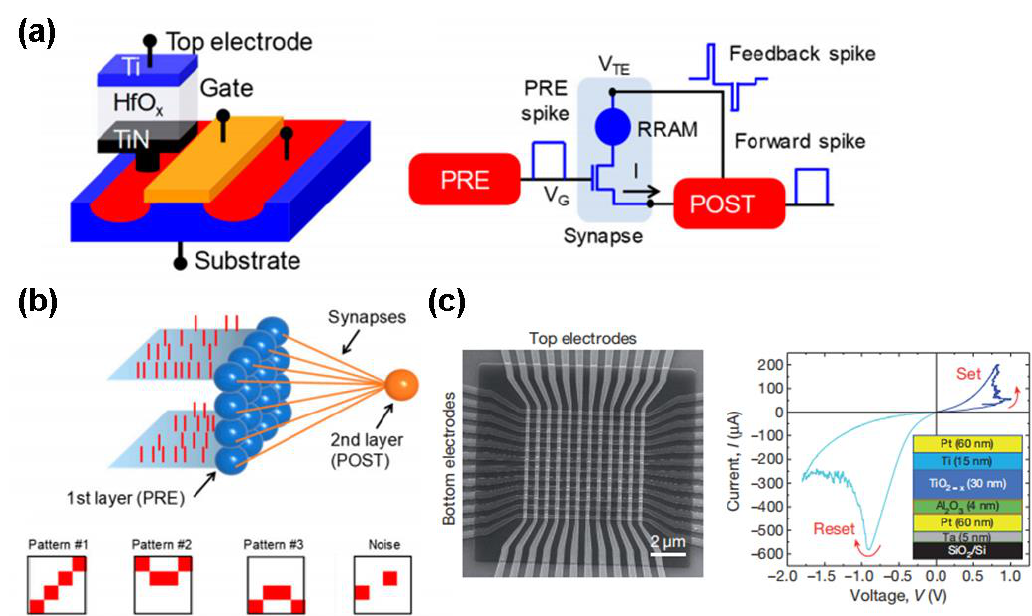
Figure 19. ( a ) Schematic structure of the 1T1R RRAM structure (left) and of the 1T1R as a synapse to achieve STDP (spike-timing-dependent-plasticity) in hardware (right); ( b ) schematic of a single-layer perceptron network where a 4 × 4 input layer is fully connected to a single post-synapse (top) and sequence of three visual patterns submitted to the neural network during training process and an example of a random noise image, which is alternatively applied to patterns according to a stochastic approach (bottom); ( c ) integrated 12 × 12 crossbar with an Al 2 O 3 / TiO 2-x memristor at each crosspoint (left) and a typical current-voltage curve of a formed memristor (right). (( a ) is reprinted with permission from [165]; ( b ) is reprinted with permission from [166]; ( c ) is reprinted with permission from [168].)